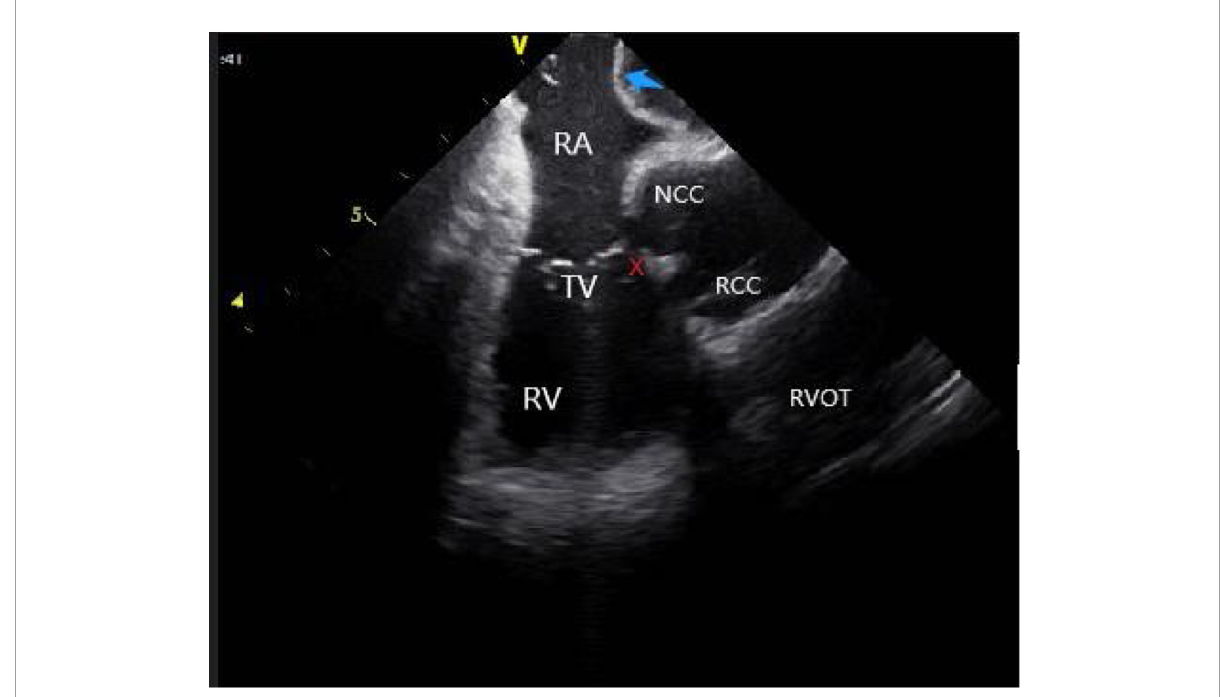
FIGURE9 The anatomy of para-his area under ICE. RV, right ventricular; RA, right atrial; NCC, non-coronary cusp; RCC, right coronary cusp; TV, tricuspid valve; RVOT, right ventricular outflow tract; Blue arrow, atrial septum; The His region is marked with an